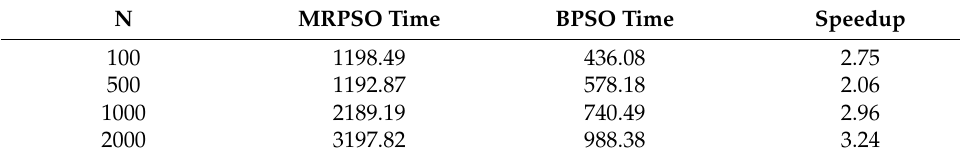
Table 2. MRPSO and BPSO running time and speedup on f 1 .